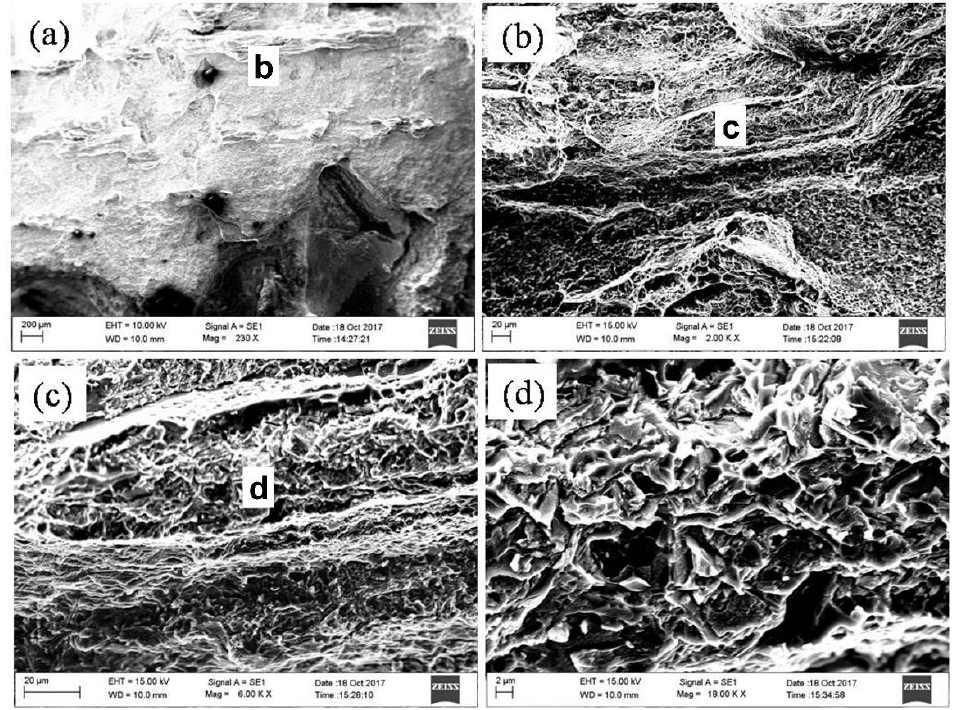
Figure 17. SEM images of a fractured surface of a tensile-test specimen of EB weld. ( a ) A region of the fracture surface at low magnification; ( b – d ) high-magnification fractography of zones as indi- cated.